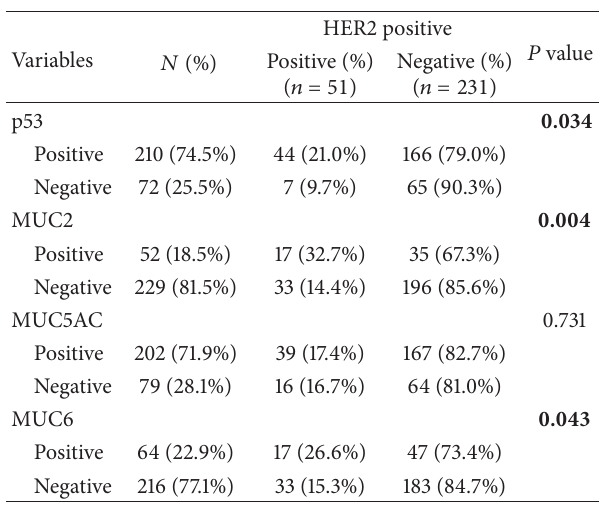
Table 2: Correlation of HER2 overexpression with MUC2, MUC5AC, MUC6, and p53.